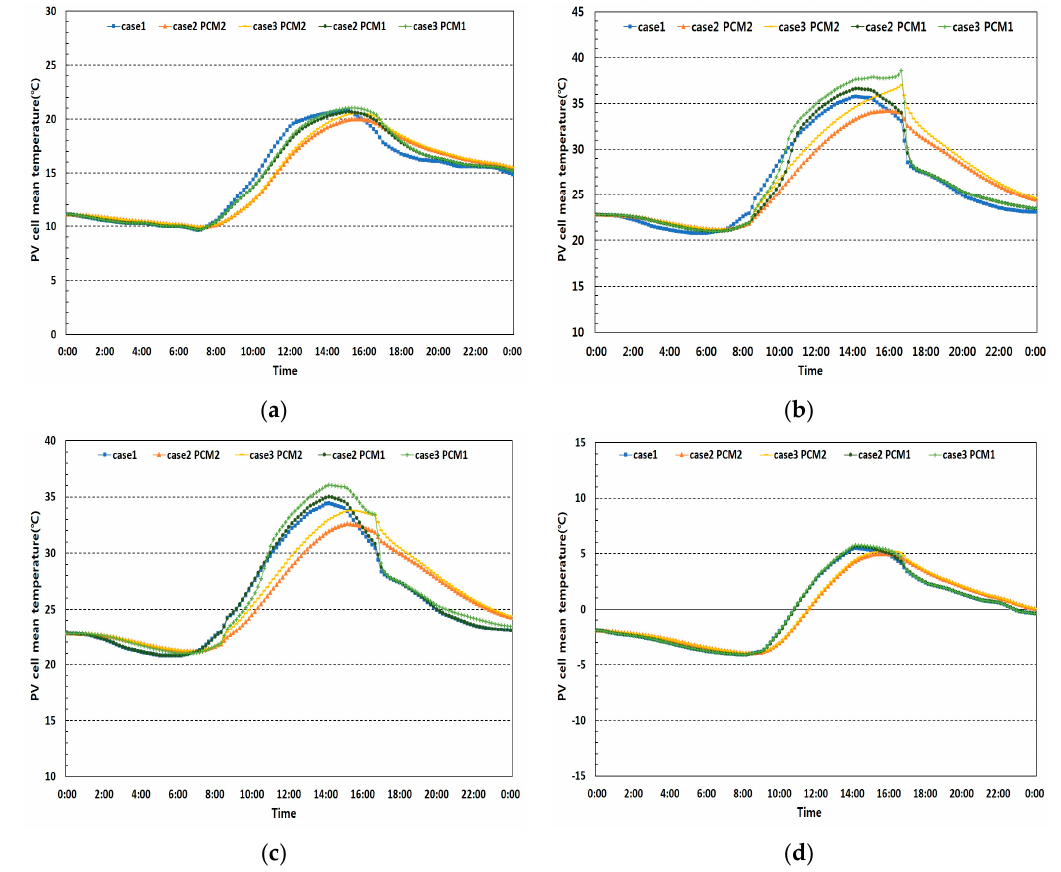
Figure 6. Mean operating temperatures of PV cell under the different weather conditions: ( a ) cloudy sky and moderate temperature (intermediate season); ( b ) clear sky and hot temperature (summer season); ( c ) cloudy sky and hot temperature (summer season); and ( d ) cloudy sky and cold temperature (winter season).